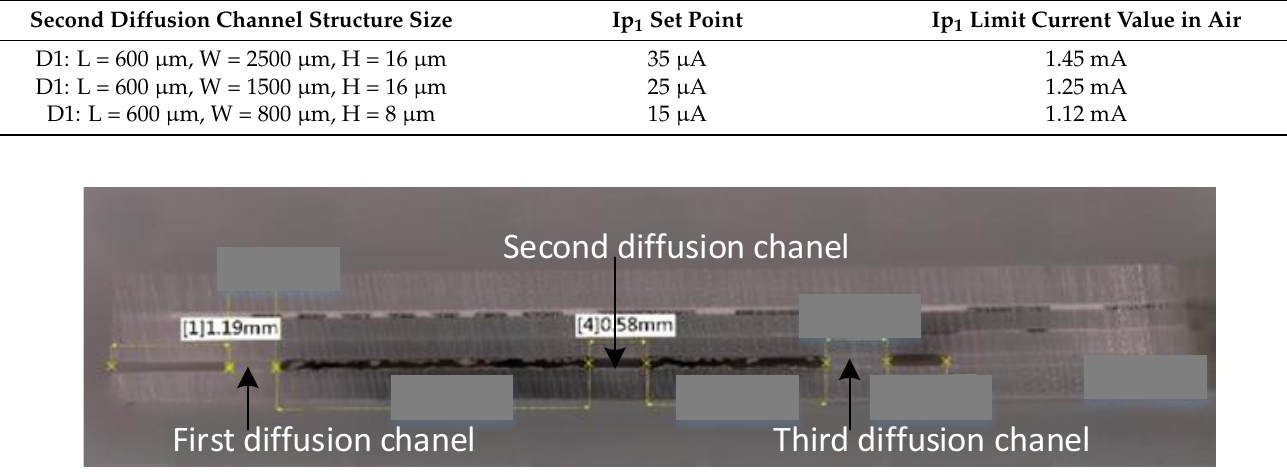
Figure 14. The slice diagram of ceramic element. Table 2. Ip 1 set point for different structure sizes of the second diffusion channel.